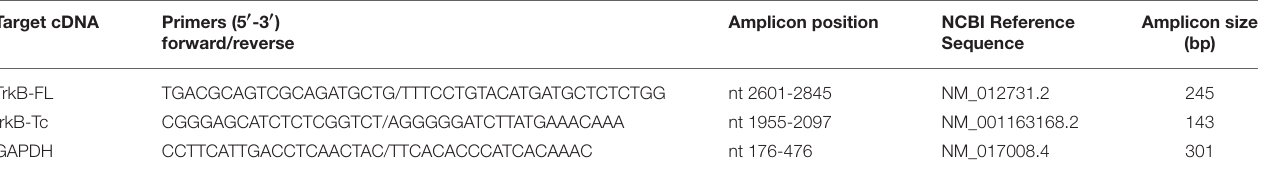
TABLE 1 | Primers used for PCR amplification. Target